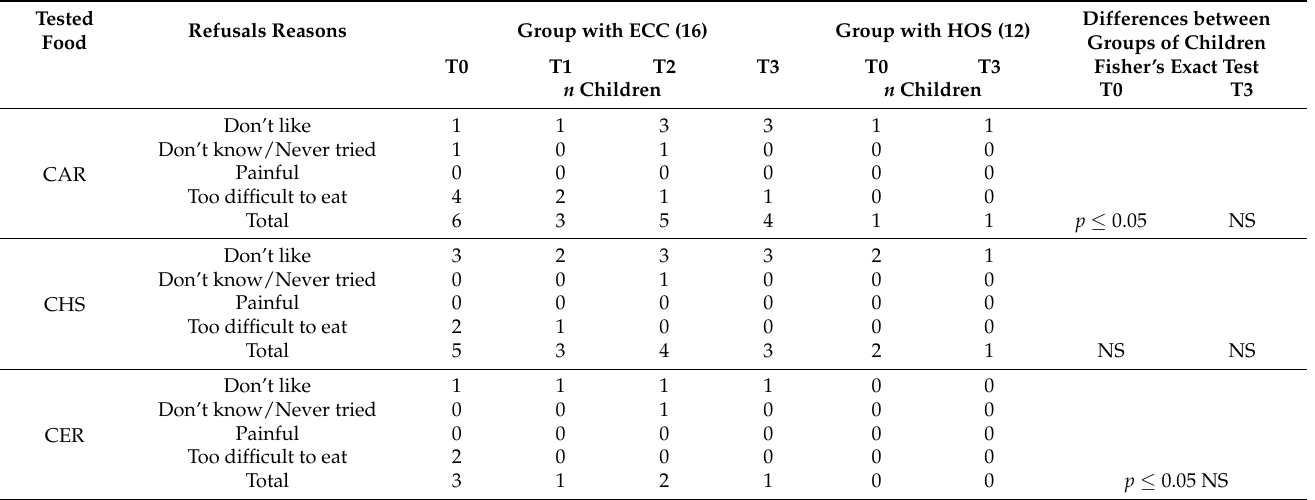
Table 3. Reasons for refusals during the mastication tests throughout the study for both groups of children.